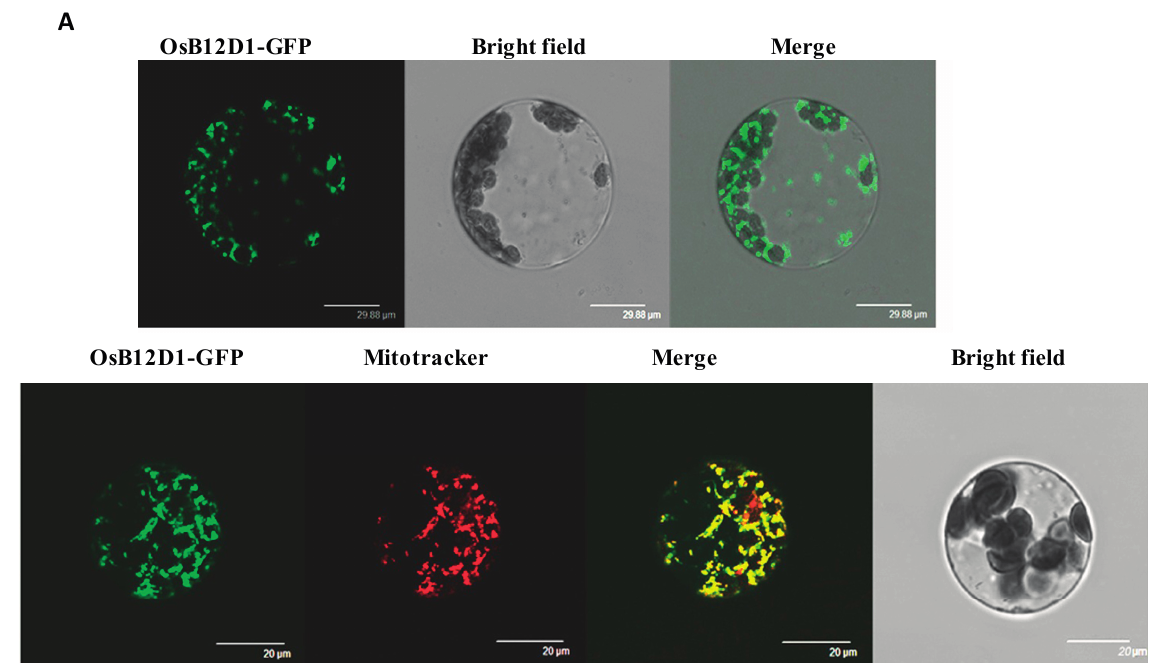
Figure 5. Subcelluar localization of OsB12D1 and the expressional patterns of electron transfer-related genes. ( A ) Transient expression of OsB12D1-gfp in the Arabidopsis leaf protoplast. OsB12D1-GFP, green fluorescence of OsB12D1-GFP under a dark field; Bright field, morphology of chloroplasts under a bright field; Mitotracker, red fluorescence of mitochondria stained by MitoTracker Red (Molecular Probes); merge, merged images of green fluorescence with Bright field or MitoTracker. Bars =29.88 or 20 μ m; ( B ) Western blot analysis displayed the OsB12D1-FLAG protein enriched in the mitochondria fractions of the percoll gradient. After ultracentrifugation for mitochondria isolation, the percoll gradient was fractionated into nine 1 mL fractions from top to bottom, and used for Western blot with the first antibody of anti-FLAG and anti-VDAC (antibody of mitochondrial mark protein); ( C ) qRT-PCR analyses of the expression of Cytc1 , OsHb2 and OsNAS3 in the seedlings of OsB12D1 -OE lines. The OsB12D1 -OE seeds were germinated under normal “N” and flooding condition “F” for three days, and then the coleoptiles were collected for qRT-PCR analyses. The expression of OsB12D1 was normalized to the expression of the rice 18S rRNA. The values are the means with the standard deviations ( n = 3), asterisks (* p < 0.01, Student’s t -test) represent significant different from WT-N expression